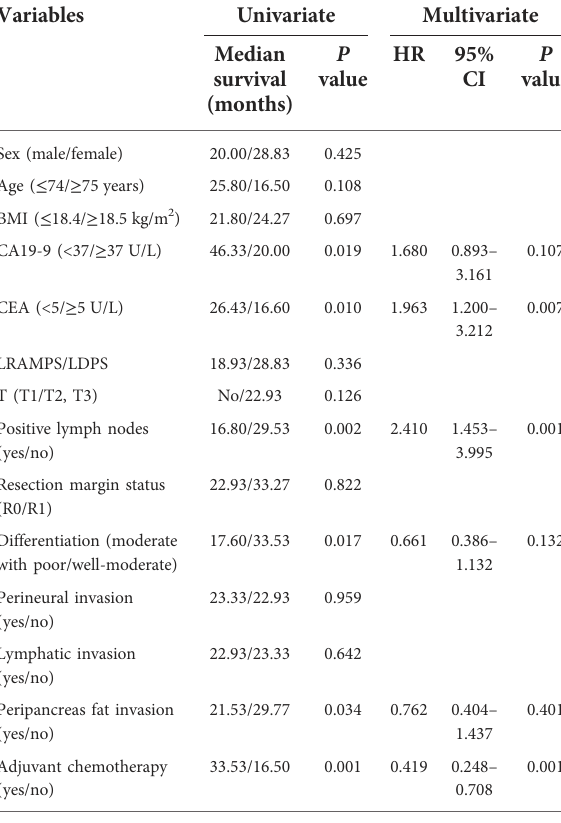
TABLE 3 Kaplan – Meier and Cox proportional hazard regression analysis of overall